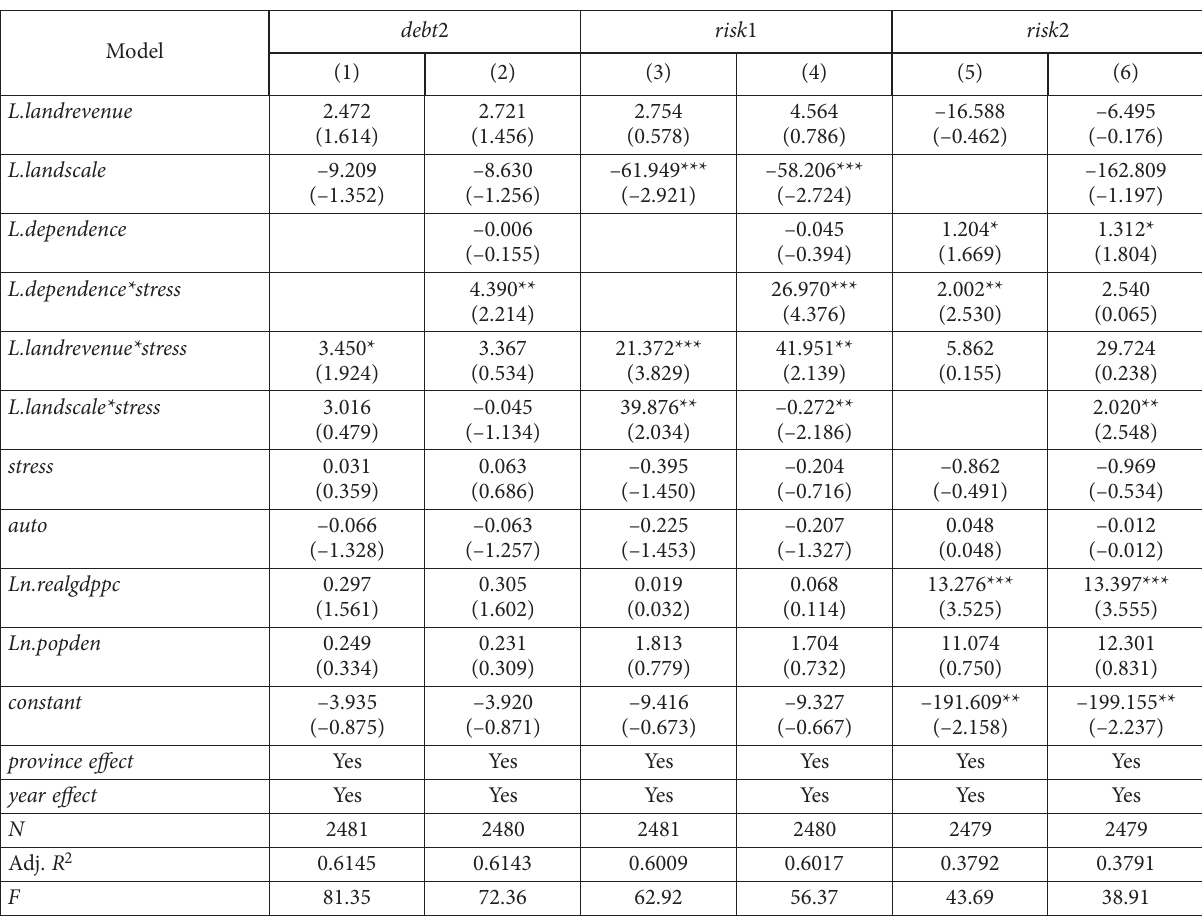
Table 4. Impact of interaction items on the debt scale and debt